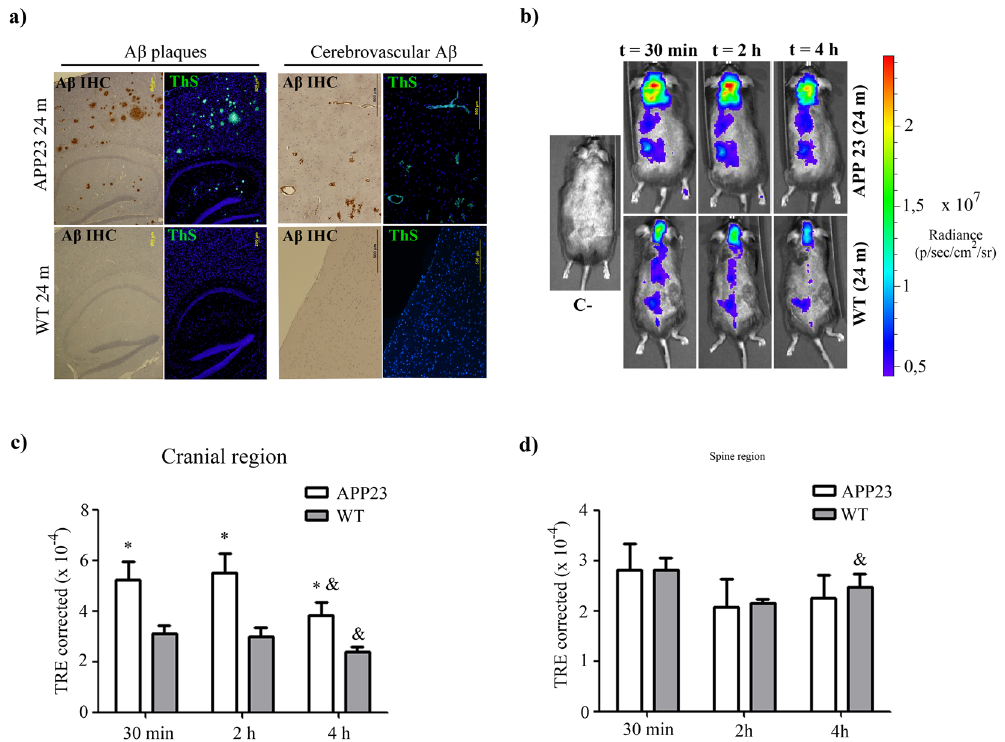
Figure 6. rHDL-rApoJ biodistribution in aged APP23 or wt mice. ( a) Brain ThS staining and A β immunohistochemistry (IHC) from 24-month-old APP23 and wt mice showing the parenchymal and vascular accumulation of fibrillary A β . (b) Representative in vivo IVIS Xenogen images of mice at 30 min, 2 h and 4 h after IV administration of labelled-rHDL-rApoJ. C − = Non-treated control mouse. Quantification of the fluorescent signal obtained in the (c) cranial region and (d) spine region after IV administration of labelled- rHDL-rApoJ nanodiscs in 24-month-old APP23 and age-matched wt mice (N = 5–6/group). t-test analysis: * p < 0.05 comparison of the signal obtained in APP23 vs. wt mice at each time point. Paired t-test analysis: & p < 0.05 comparison of t = 30 min and t = 4 h for each